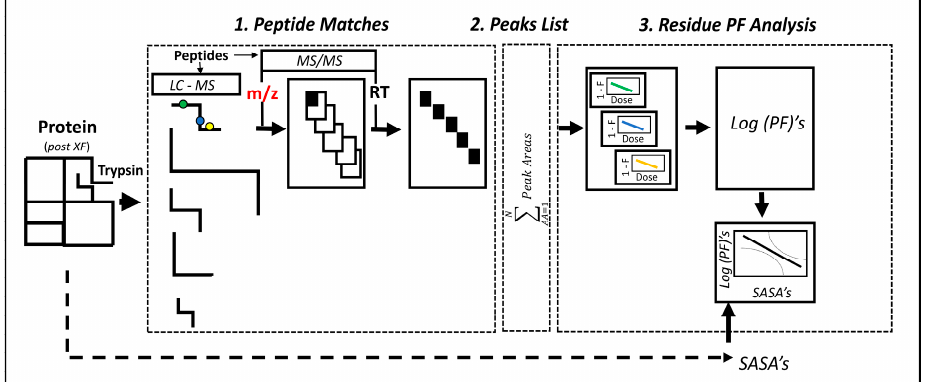
Figure 6. Semi-automated algorithm for determination of PFs and the SASA–Log (PF) relation. There are three distinct stages to the MATLAB code. The code is generally applicable. 1. The prote- olyzed (tryptic) peptides from the XF experiment were analyzed by LC-MS and MS/MS. The pipe- line illustrated for one peptide was iterated for all peptides. The resulting Mass Hunter (LC-MS) and MASCOT (MS/MS) files were matched by RT (retention time) to parse out the oxidized and unoxidized peak areas (black sections) for each residue from unrelated peaks in the lists obtained by manual entry (red) of the MASCOT m/z values. 2. A list with the oxidized and unoxidized peak areas for all detected residues in the protein was compiled. 3. Computed oxidation rates were di- vided by intrinsic reactivities for determination of residue PFs. Data for all residues were combined for the SASA versus Log (PF) relations. The SASAs were obtained from the protein crystal structure or Alpha-fold model. Residues with Log (PF) values below the 95% confidence limit for the best-fit linear relation were designated as ALPRs (anomalous protection factor residues). See Appendix A for details.